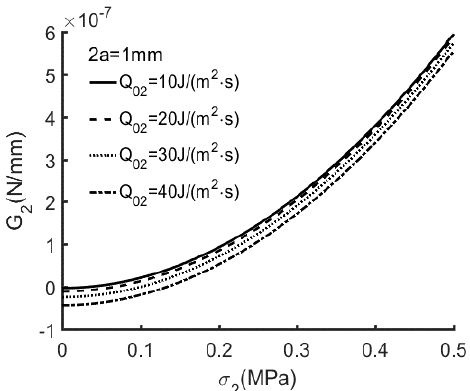
(cid:0) (cid:1) m 2 · s for (cid:118) c = 0 and ε = 0.01.